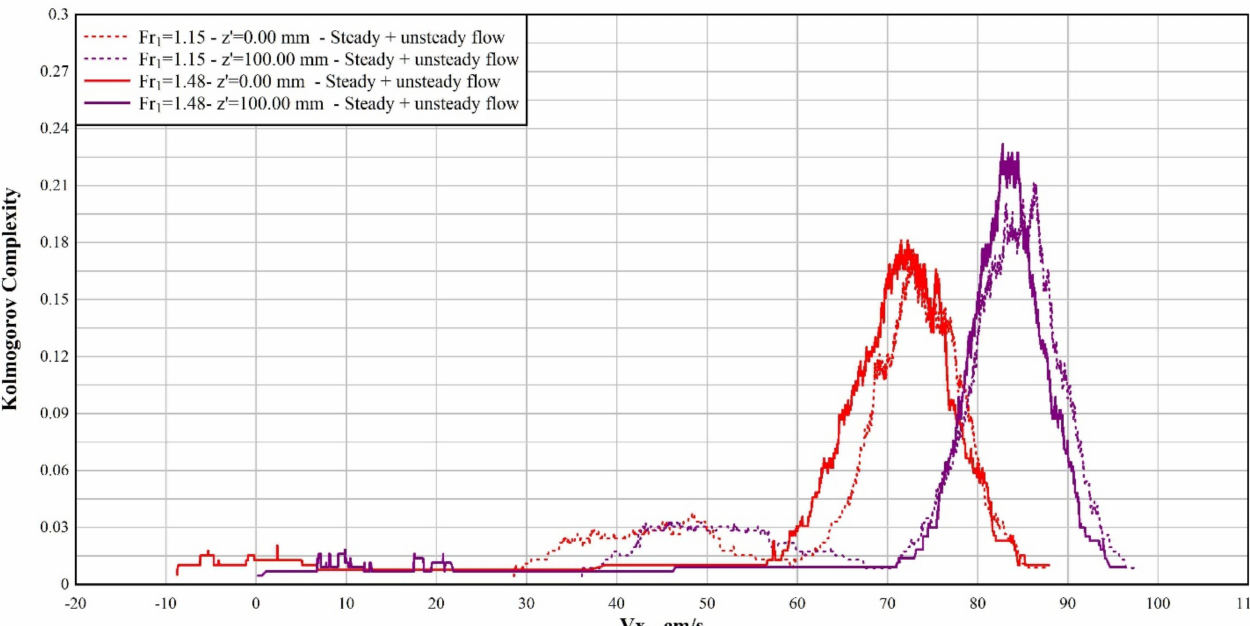
Figure 10. Undular surge, Run 60-7, and breaking surge Run 60-6. Kolmogorov complexity spectra for V x at z (cid:48) = 0.00 mm and 100 mm.